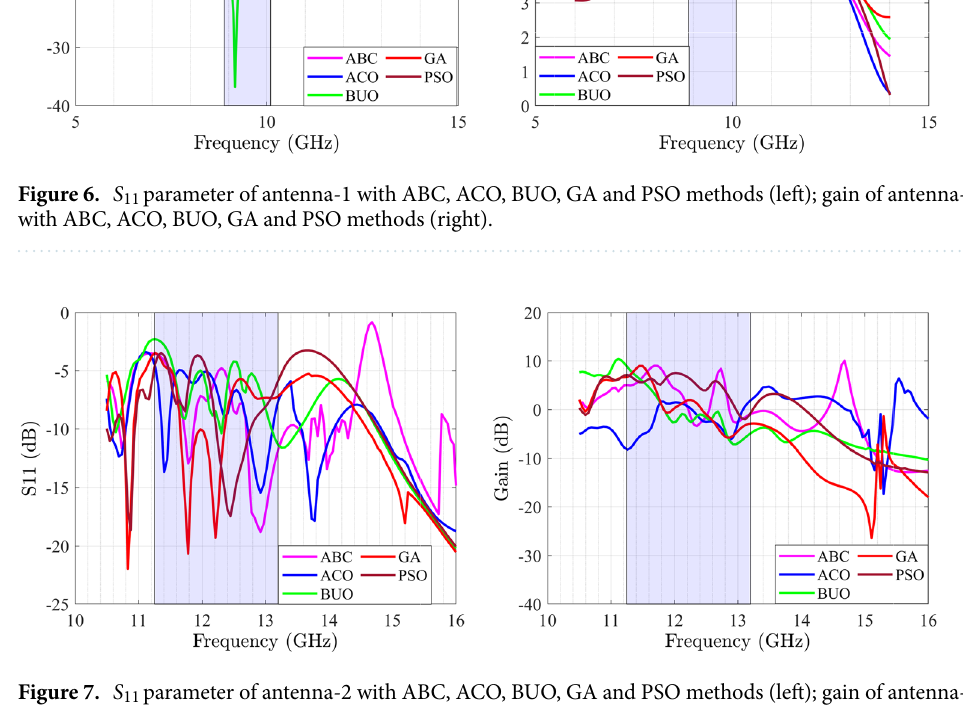
Figure 7. S 11 parameter of antenna-2 with ABC, ACO, BUO, GA and PSO methods (left); gain of antenna-2 with ABC, ACO, BUO, GA and PSO methods (right).